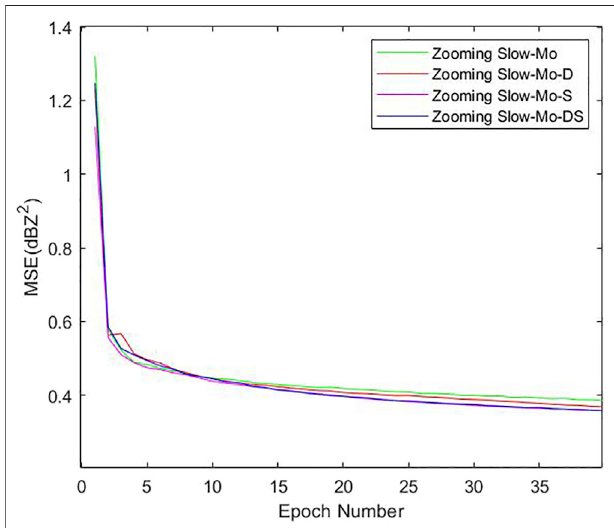
FIGURE 10 | Loss function curve.